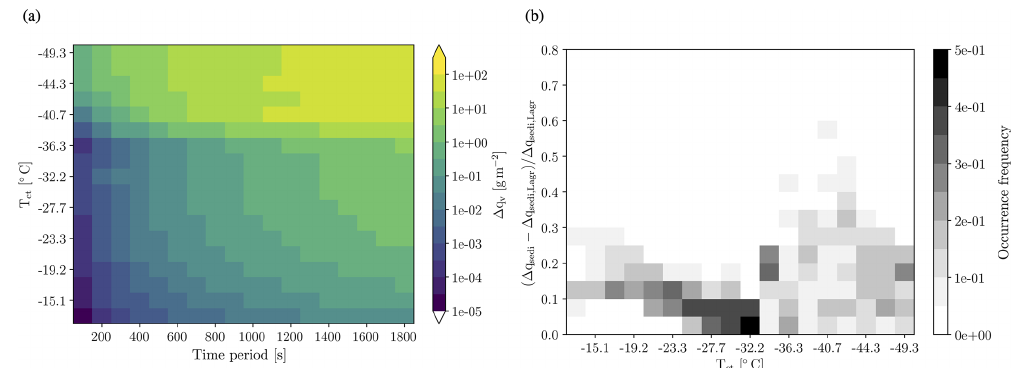
Figure 13. (a) Total downward transport of water predicted using Eqs. (3) to (8) across wave clouds with vertical extent z c of 2m, the DM10 heterogeneous freezing parameterization, and various cloud top temperatures (ordinate) as well as periods (abscissa). (b) Normalized difference between (cid:49)q t predicted by the conceptual model and the full KiD model for different cloud top temperatures. The data shown in (b) include the full simulations set with all cloud top temperature, wavelength, and cloud thickness specified in Sect.